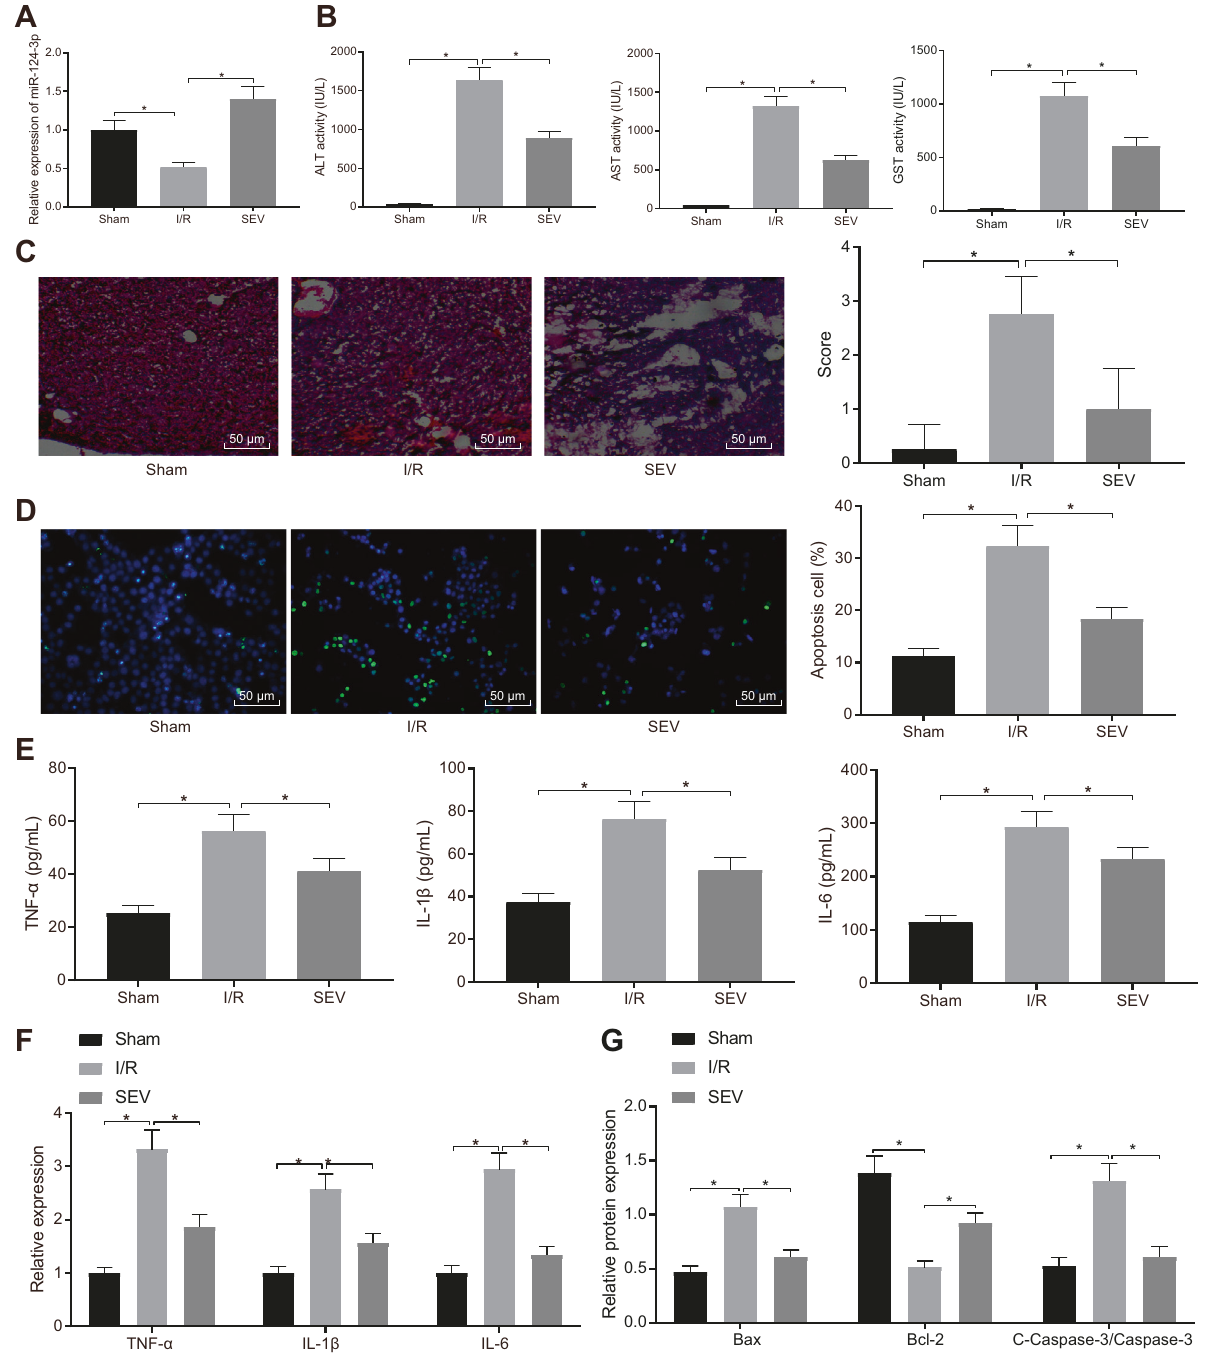
Fig. 1 SEV promotes the expression of miR-124-3p and alleviates hepatic I/R injury in mice. A The expression of miR-124-3p in liver tissues of sham-operated mice, I/R mice or I/R mice treated with SEV detected by RT-qPCR. B Serum levels of GST, ALT, and AST in sham-operated mice, I/R mice or I/R mice treated with SEV detected by ELISA. C Liver tissue injury in sham-operated mice, I/R mice or I/R mice treated with SEV determined by HE staining (200×). D Hepatocyte apoptosis in sham-operated mice, I/R mice or I/R mice treated with SEV detected by TUNEL staining (200×). E Serum levels of TNF- α , IL-1 β , and IL-6 in sham-operated mice, I/R mice or I/R mice treated with SEV detected by ELISA. F The expression of TNF- α , IL-1 β , and IL-6 in liver tissues of sham-operated mice, I/R mice or I/R mice treated with SEV detected by RT-qPCR. G The protein expression of Bax, Bcl-2, and cleaved-caspase-3 in liver tissues of sham-operated mice, I/R mice or I/R mice treated with SEV detected by Western blot analysis. * p < 0.05 ( n = 8).